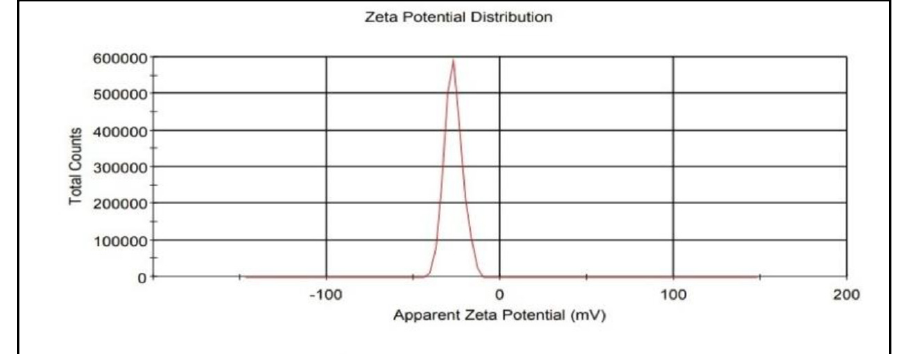
Figure 5. Determining the zeta potential of IONPs.